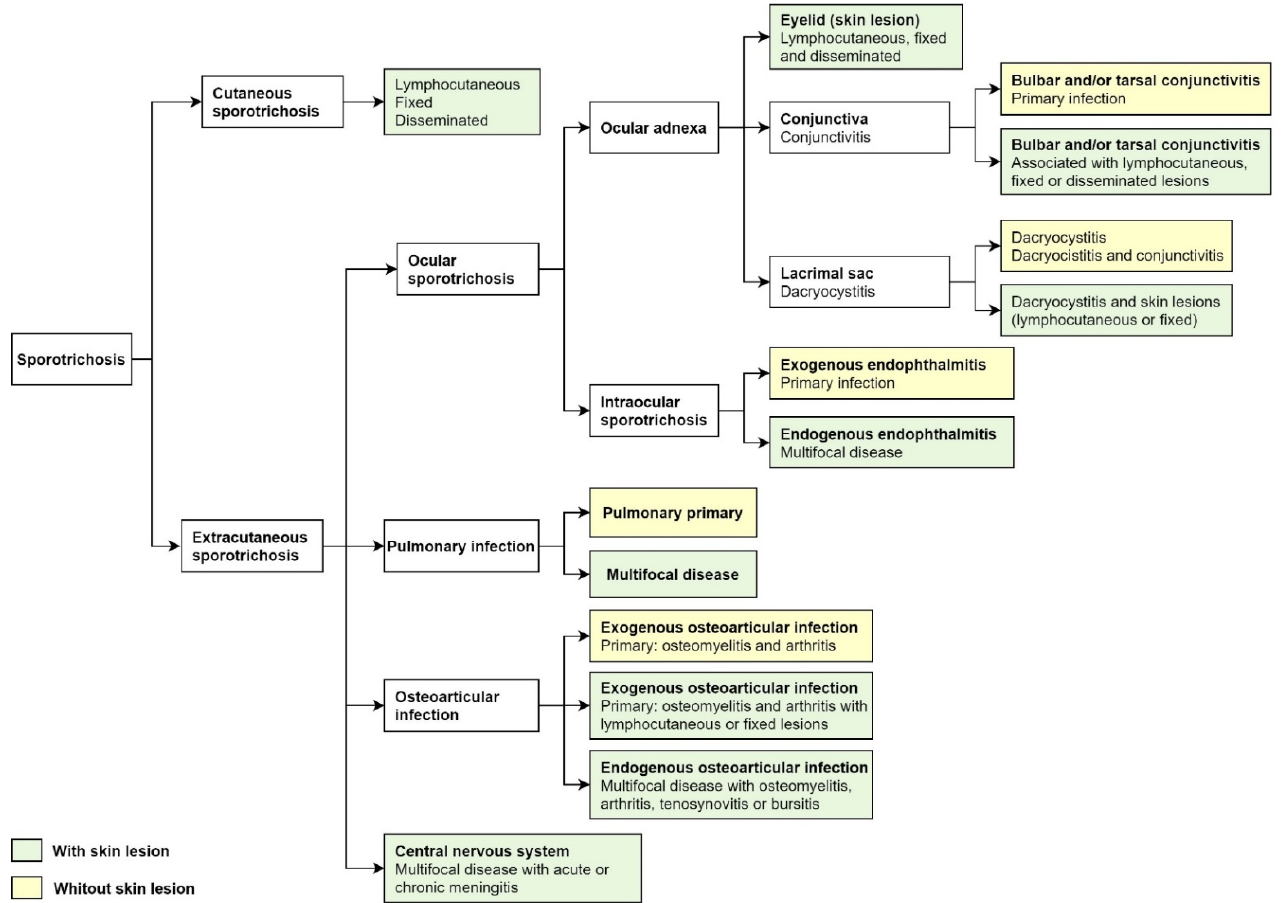
Figure 2. Cutaneous and extracutaneous sporotrichosis. For the classification of ocular sporotrichosis, anatomic criteria and source infection.